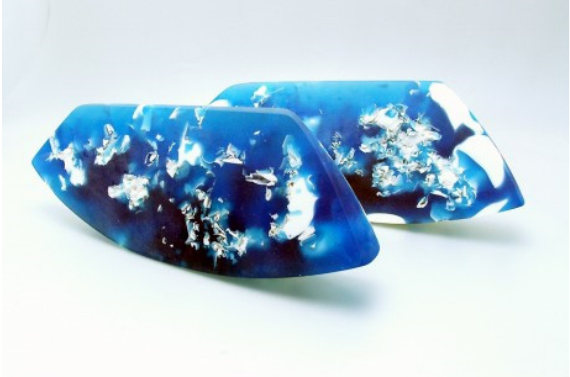
Figure 1. Jessamy Kelly; Wedge ; 2009; turquoise and clear, kiln cast glass sculpture with compatible pre-fired bone china aggregate inclusions; photo credit: the artist, used with permission.